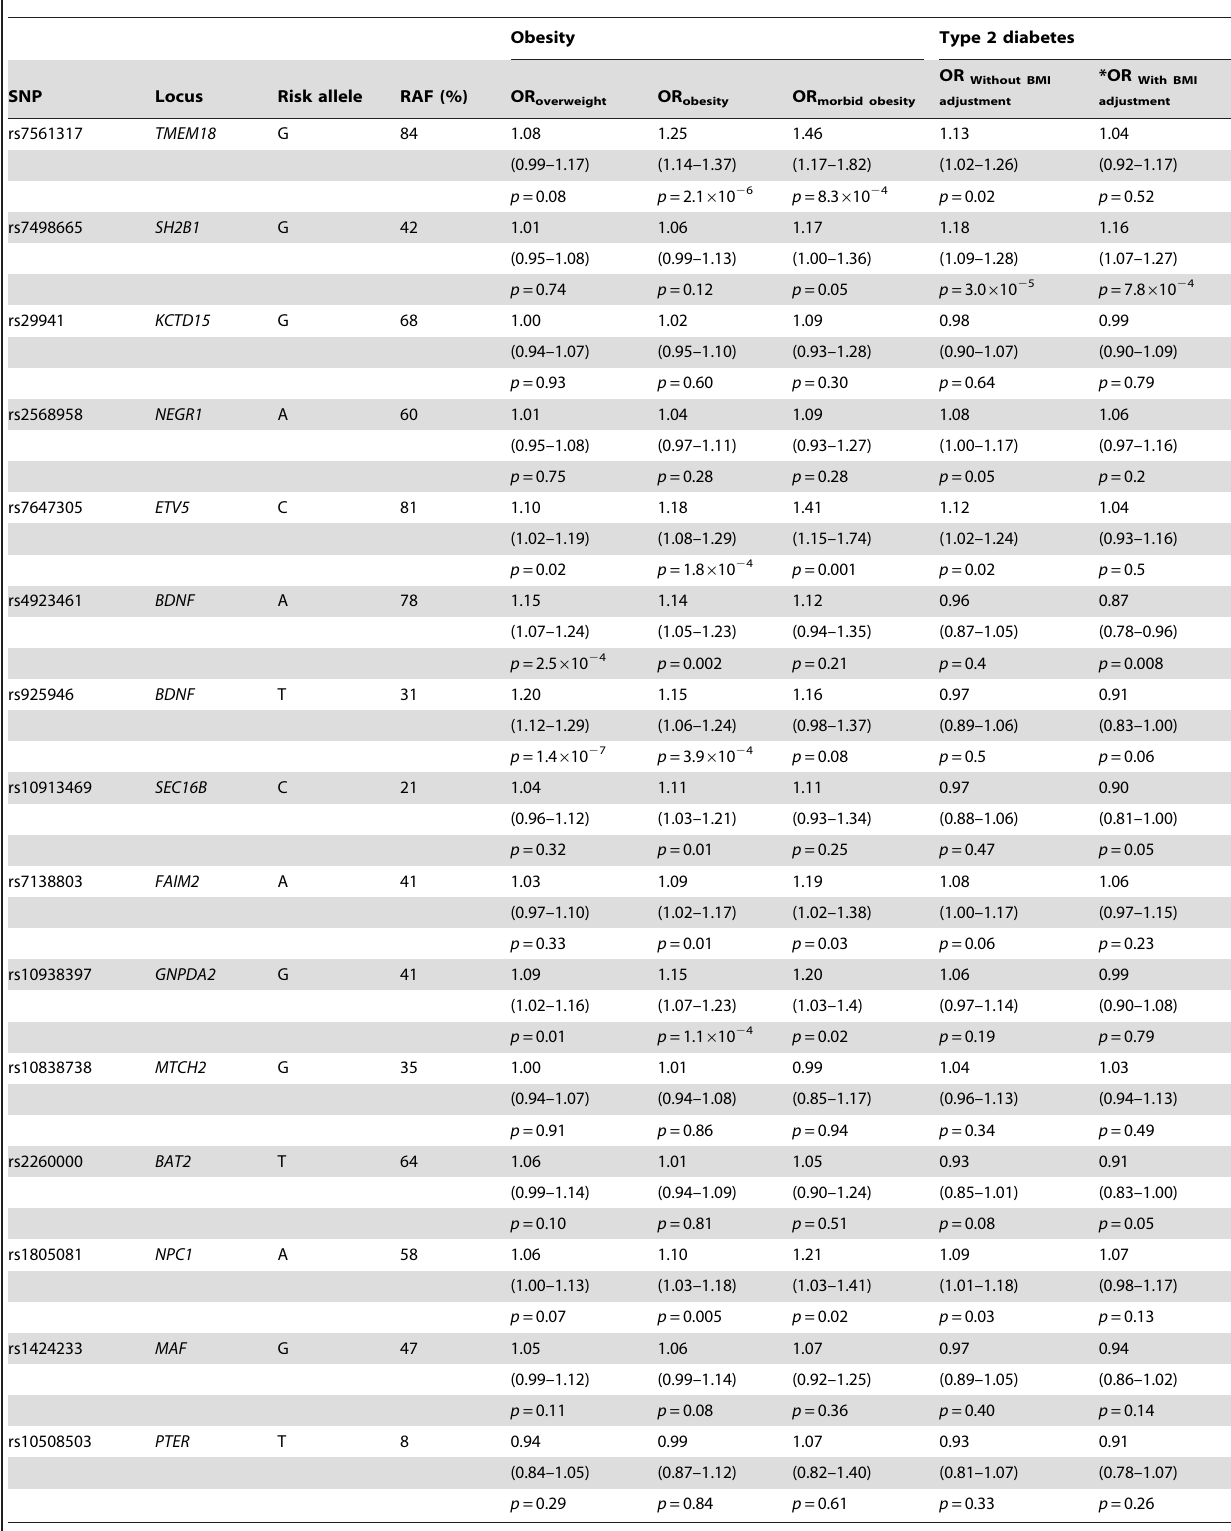
Table 1. Case-control studies of overweight, obesity and type 2 diabetes in the combined study